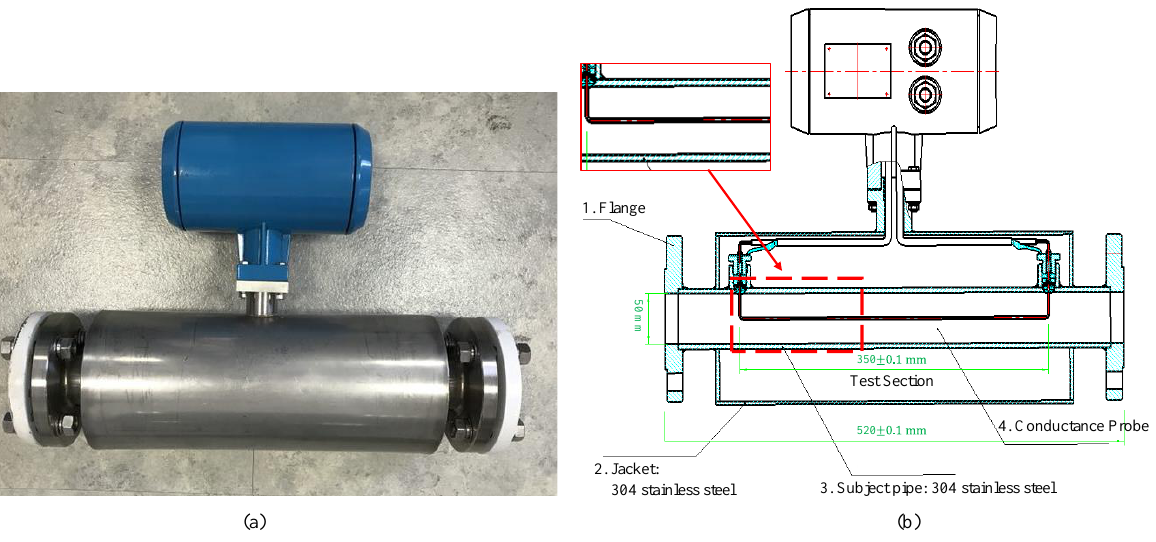
Figure 3. ( a ) Photograph of the water holdup instrument designed for the experiments. ( b ) The internal structure of the water holdup instrument.